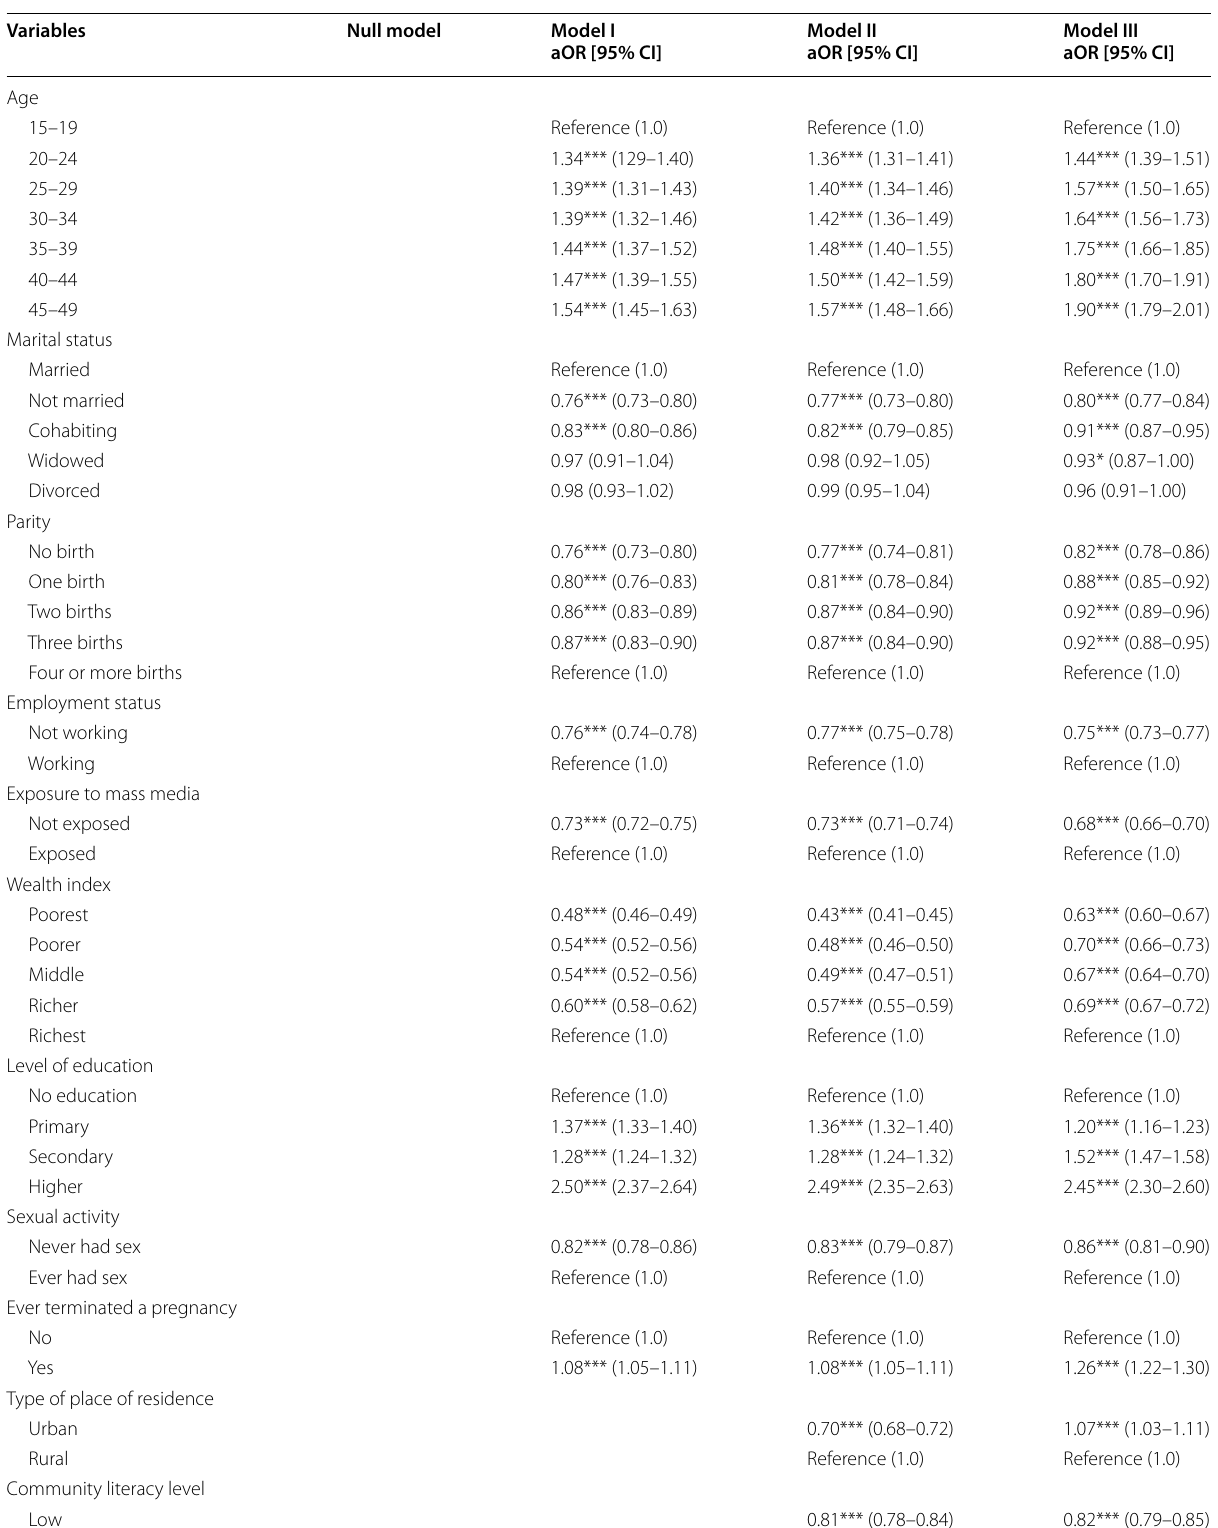
Table 3 Fixed effect (measures of association) results on the factors associated with awareness of obstetric fistula among women in sub‑Saharan